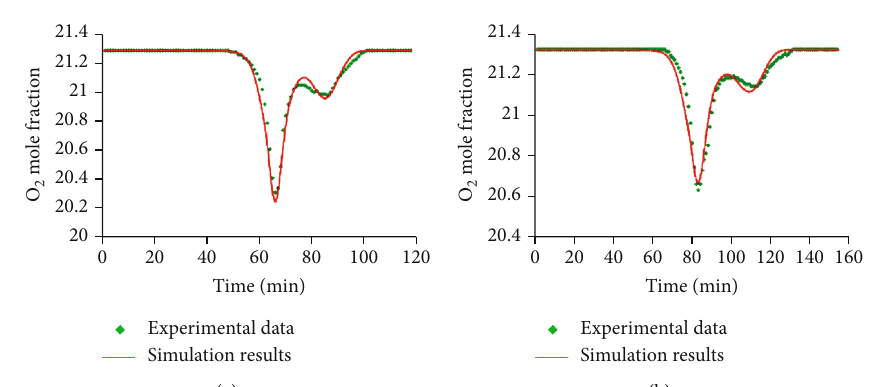
Figure 7: (a) O consumption history match for the kinetic cell (RTO) experiments with heating rates of 5.22 ° C/min; (b) O 2 history match for the kinetic cell (RTO) experiments with heating rates of 3.22 °